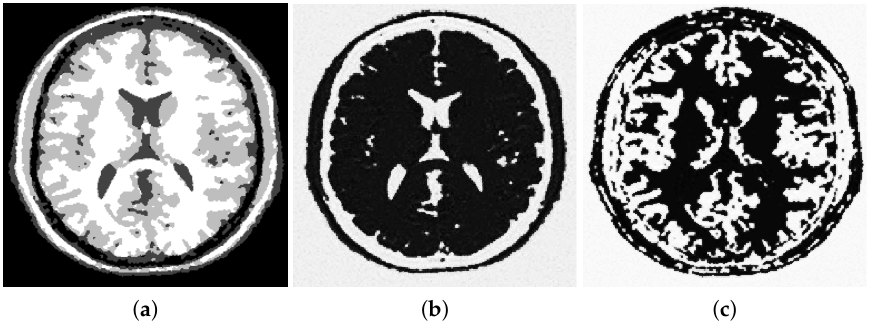
Figure 3. ( a ) the overall segmentation output of the proposed method, ( b ) output φ 1 , ( c ) output φ 2 .